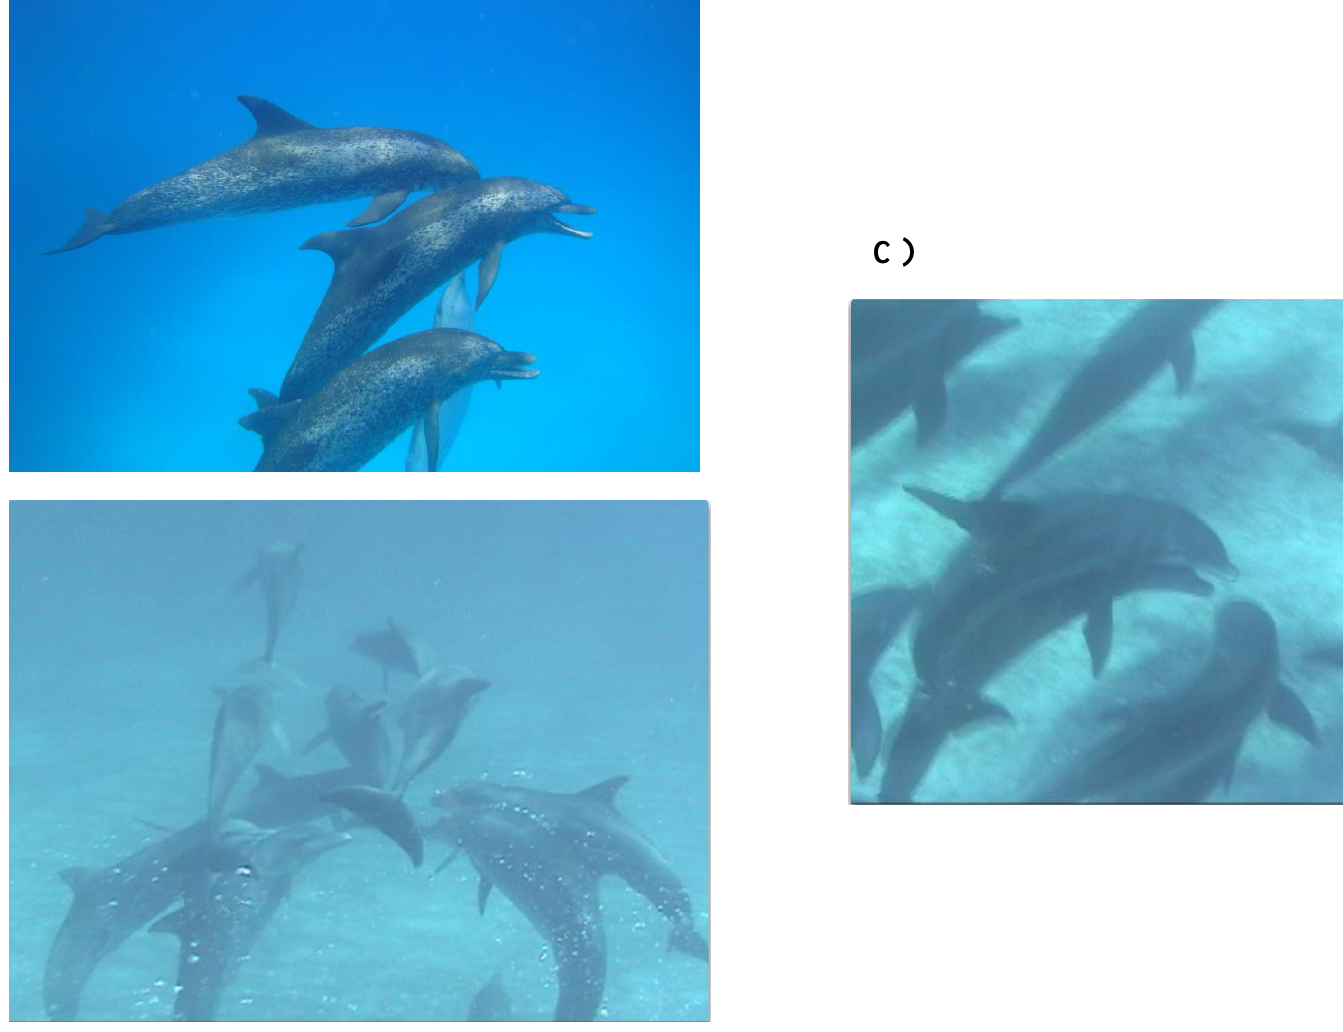
Figure 1 . Behaviors observed during synchronized vocalizations. A) Male Atlantic spotted dolphins chase bottlenose during Synchronized Squawks and Synchronized Screams, B) Male Atlantic bottlenose dolphins dyads go head-to-head and expel bubbles, and C) Male Atlantic bottlenose dolphin dyads coordinate orientation during whistle/buzzes, bray/buzzes, and synchronized